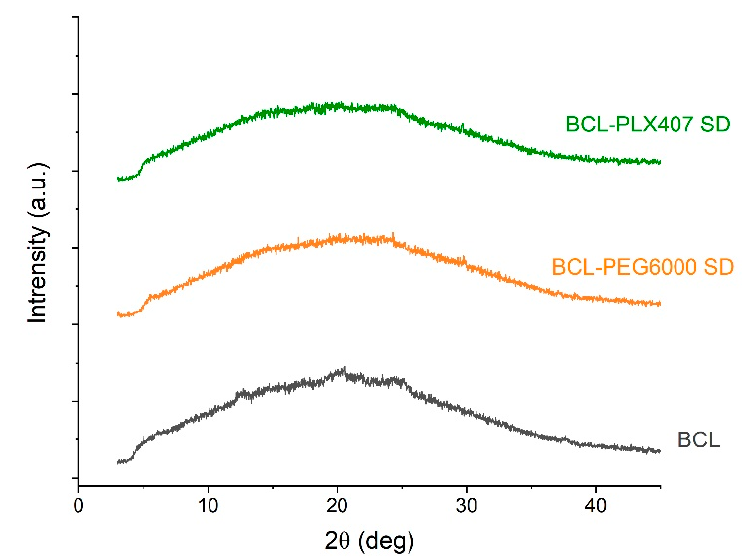
Figure 6. Diffraction patterns of tablets containing raw bicalutamide and solid dispersions.